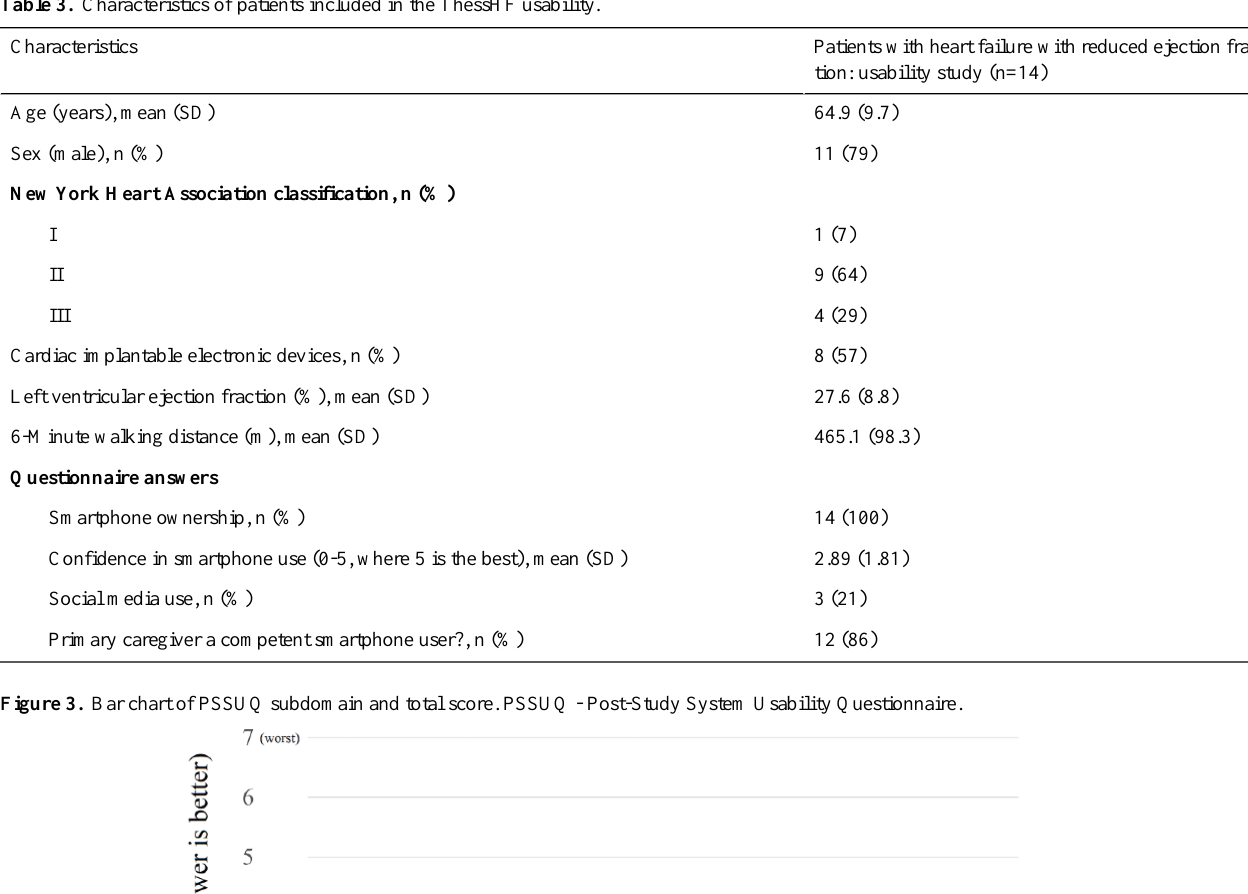
Table 3. Characteristics of patients included in the ThessHF usability.